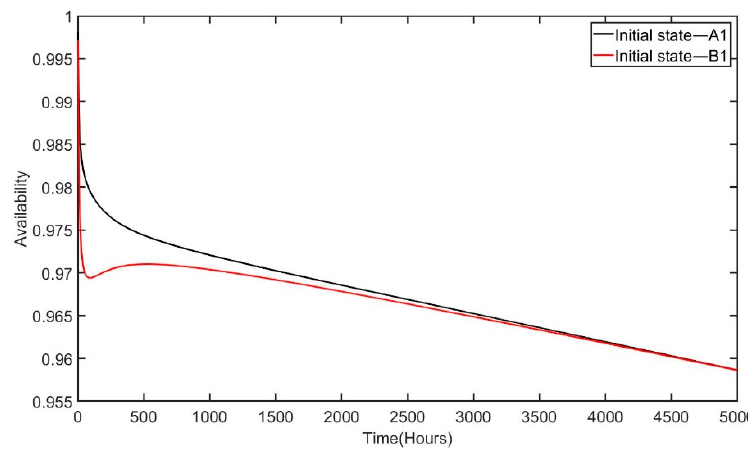
Figure 4. The average instantaneous availability of one CNC machine tool under different initial states.